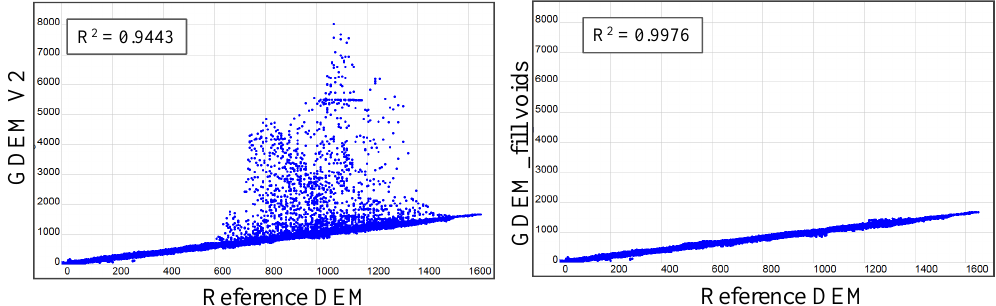
Figure 3. Correlation between GDEM and the reference DEM before (left panel) and after (right panel) filling voids.